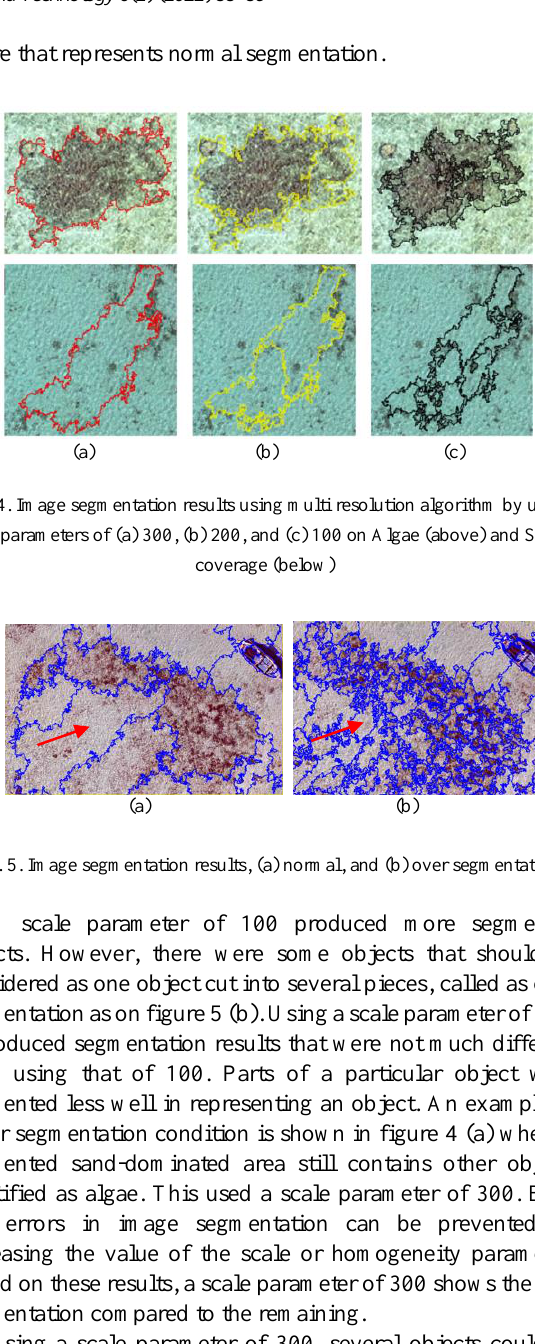
Fig. 3. Level 2 of image segmentation